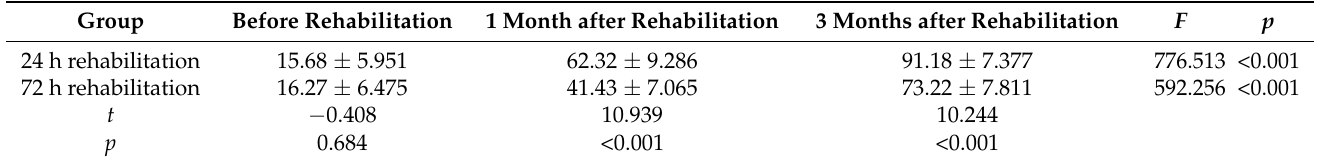
Table 2. The FMA scores of with acute ischemic stroke patients before and after rehabilitation ( x ± s, n = 75).